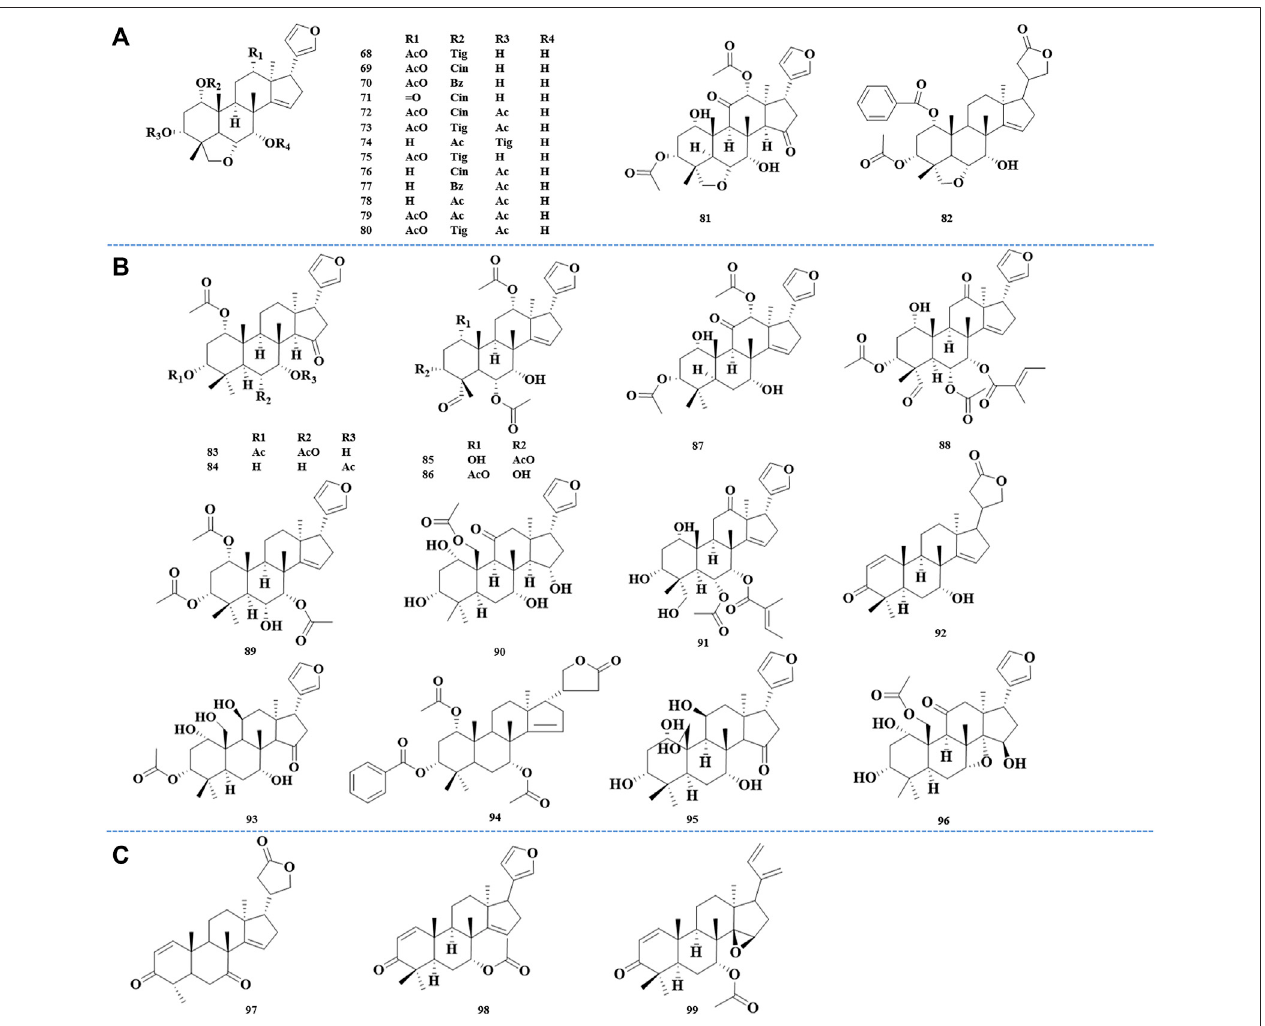
FIGURE 3 | Structures of vilasinin class limonoids 68 – 82 (A) , structures of havanensin class limonoids 83 – 96 (B) , and structures of azadirone class limonoids 97 –– 99 (C) .